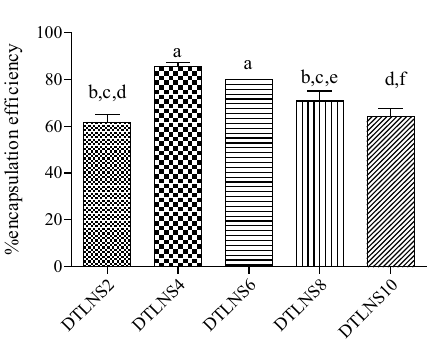
Fig. 3 Encapsulation efficiency of nanosponges formulations. All data are expressed as mean standard deviation ( n 3). Data were ± = analyzed by one-way ANOVA, followed by Bonferroni’s multiple comparison test. a indicates *** p < 0.0001 versus DTLNS2, b indicates * p < 0.05 versus DTLNS2, c indicates ** p < 0.001 versus DTLNS4, d indicates *** p < 0.0001 versus DTLNS4, e indicates * p < 0.05 versus DTLNS6 and f indicates ***0.0001 versus DTLNS6. Abbreviations: DTLNS stands for dithranol-loaded